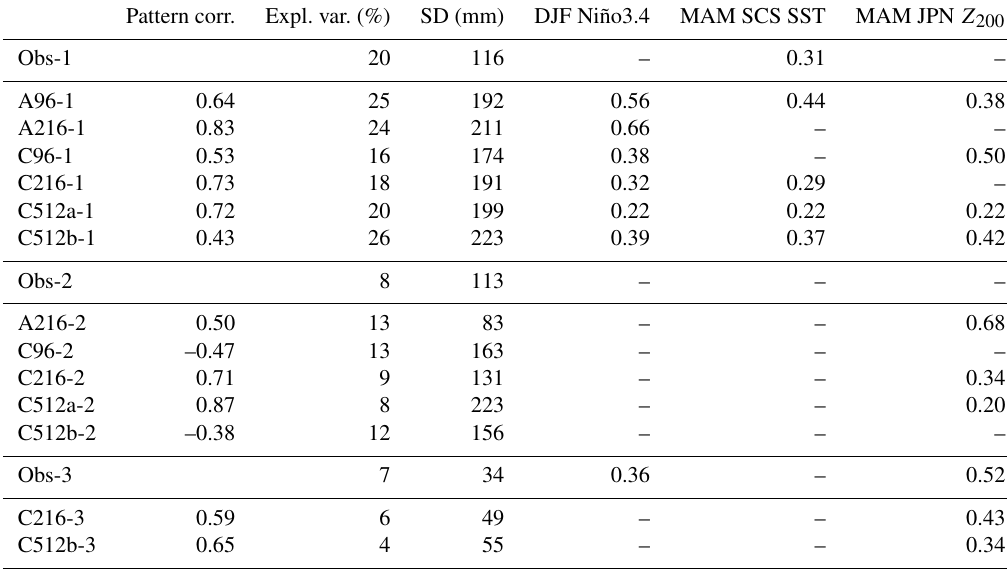
Table 2. Performance statistics of simulated EOTs compared to observations for MAM. Column (1) observed (Obs) and simulated (labelled by simulation name) EOT patterns; numbers indicate the order of the EOT pattern. (2) Linear pattern correlation coefficient of simulated and observed precipitation anomalies; (3) explained space–time variance of the EOT pattern; (4) standard deviation of the EOT time series; (5)– (7) Spearman’s rank correlation of the EOT time series with the (5) DJF Niño3.4 SST index; (6) MAM SCS SST index and (7) MAM Z 500 index over Japan (defined in Sect. 2.3). Correlation coefficients in (5)–(7) are shown only when they are significant at the 95% confidence